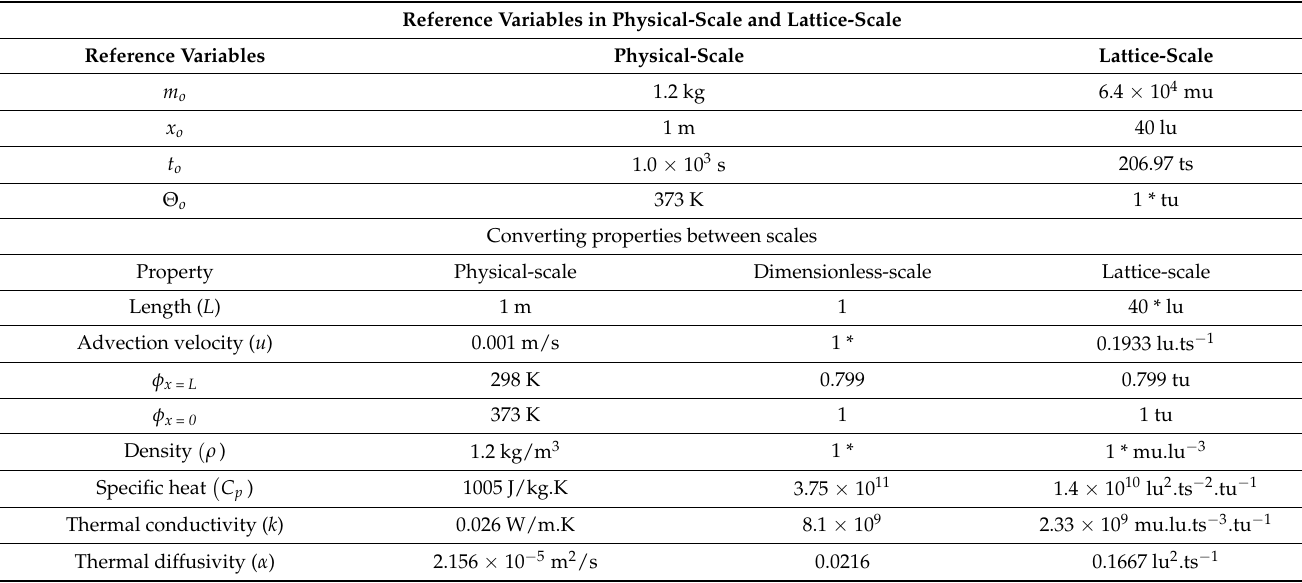
Figure 7. Comparison of the LBM and finite difference method (FDM) for different mesh sizes. The LBM solution is achieved at the lattice-scale then converted to the physical-scale. Table 5. Converting data for the advection-diffusion problem. The values with * represent assumed